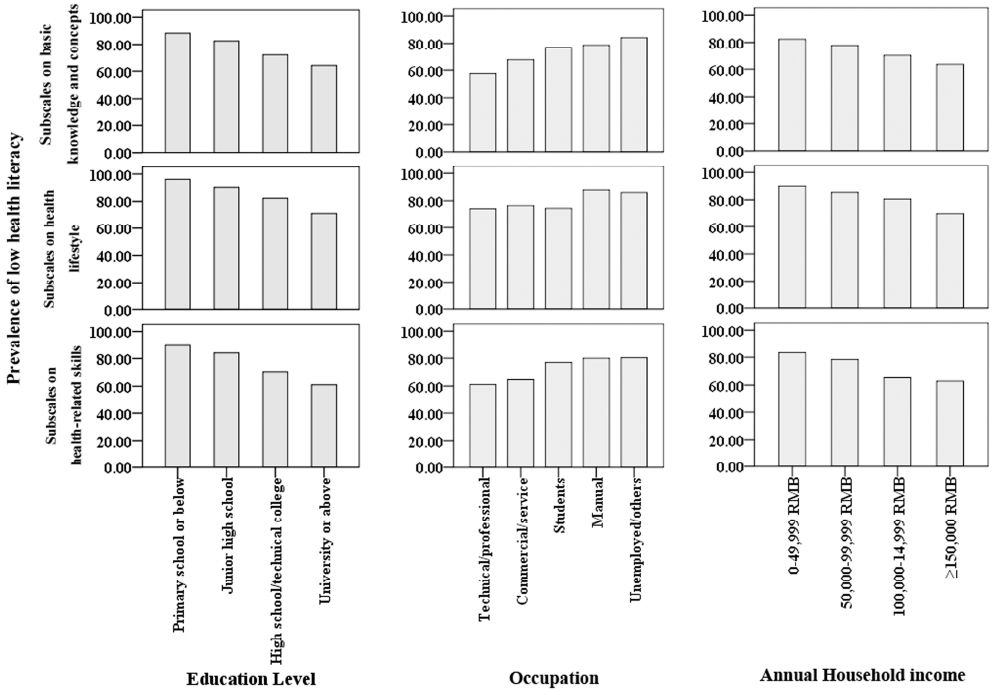
Figure 4. Prevalence of low health literacy by three subscales and characteristics.